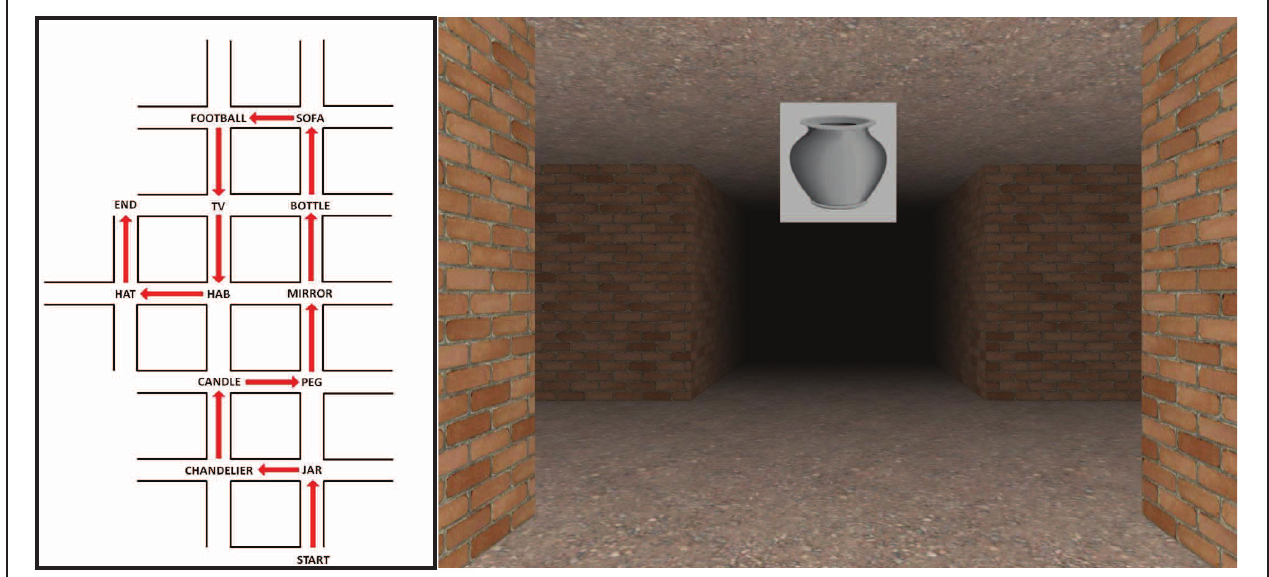
FIGURE 1 | Left: schematic drawing of the route consisting of 11 intersections; right: screen-shot of one of the intersections.